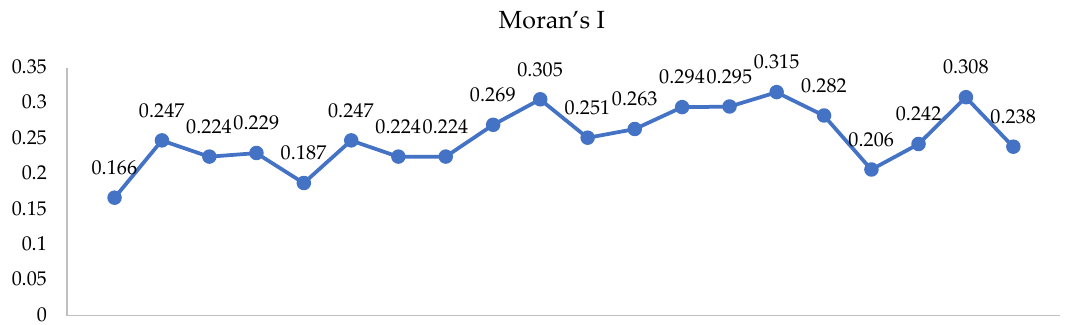
Figure 1. Moran’s I-value trends of PSE’s NABIT among Taiwanese cities from 2001 to 2020. Anselin [38] divides the local indicator of spatial association (LISA) statistics into four quadrants according to the degree of spatial clustering, to indicate the spatial relationships between this region and the neighboring regions. LISA provides an explanatory model of spatial intera ctions. Moran’s I is unable to reveal spatial clustering among cities or the spatial autocorrelation of different regions, and LISA can address this gap. Among the four quadrants of LISA (Figure 2), the first and the third quadrants are the areas where similar values cluster. The first quadrant shows a high degree of clustering, while the third quadrant shows a low degree of clustering. The first and third quadrants represent the pull-through effect, i.e., the influence caused by changes in the nearby regions. This is usually referred to as the basis of spatial diffusion. Significant and positive spatial autocorrelation refers to a given region being surrounded by regions of similar attribute values. This is known as spatial clustering. A spatial cluster can be classified as either a hot spot or a cold spot. The first quadrant indicates hot spots (denoted as High-High), in which the observed values are high for both the researched region and the adjacent regions. The third quadrant indicates cold spots (Low-Low), in which the observed values are low for both the researched region and the adjacent regions.